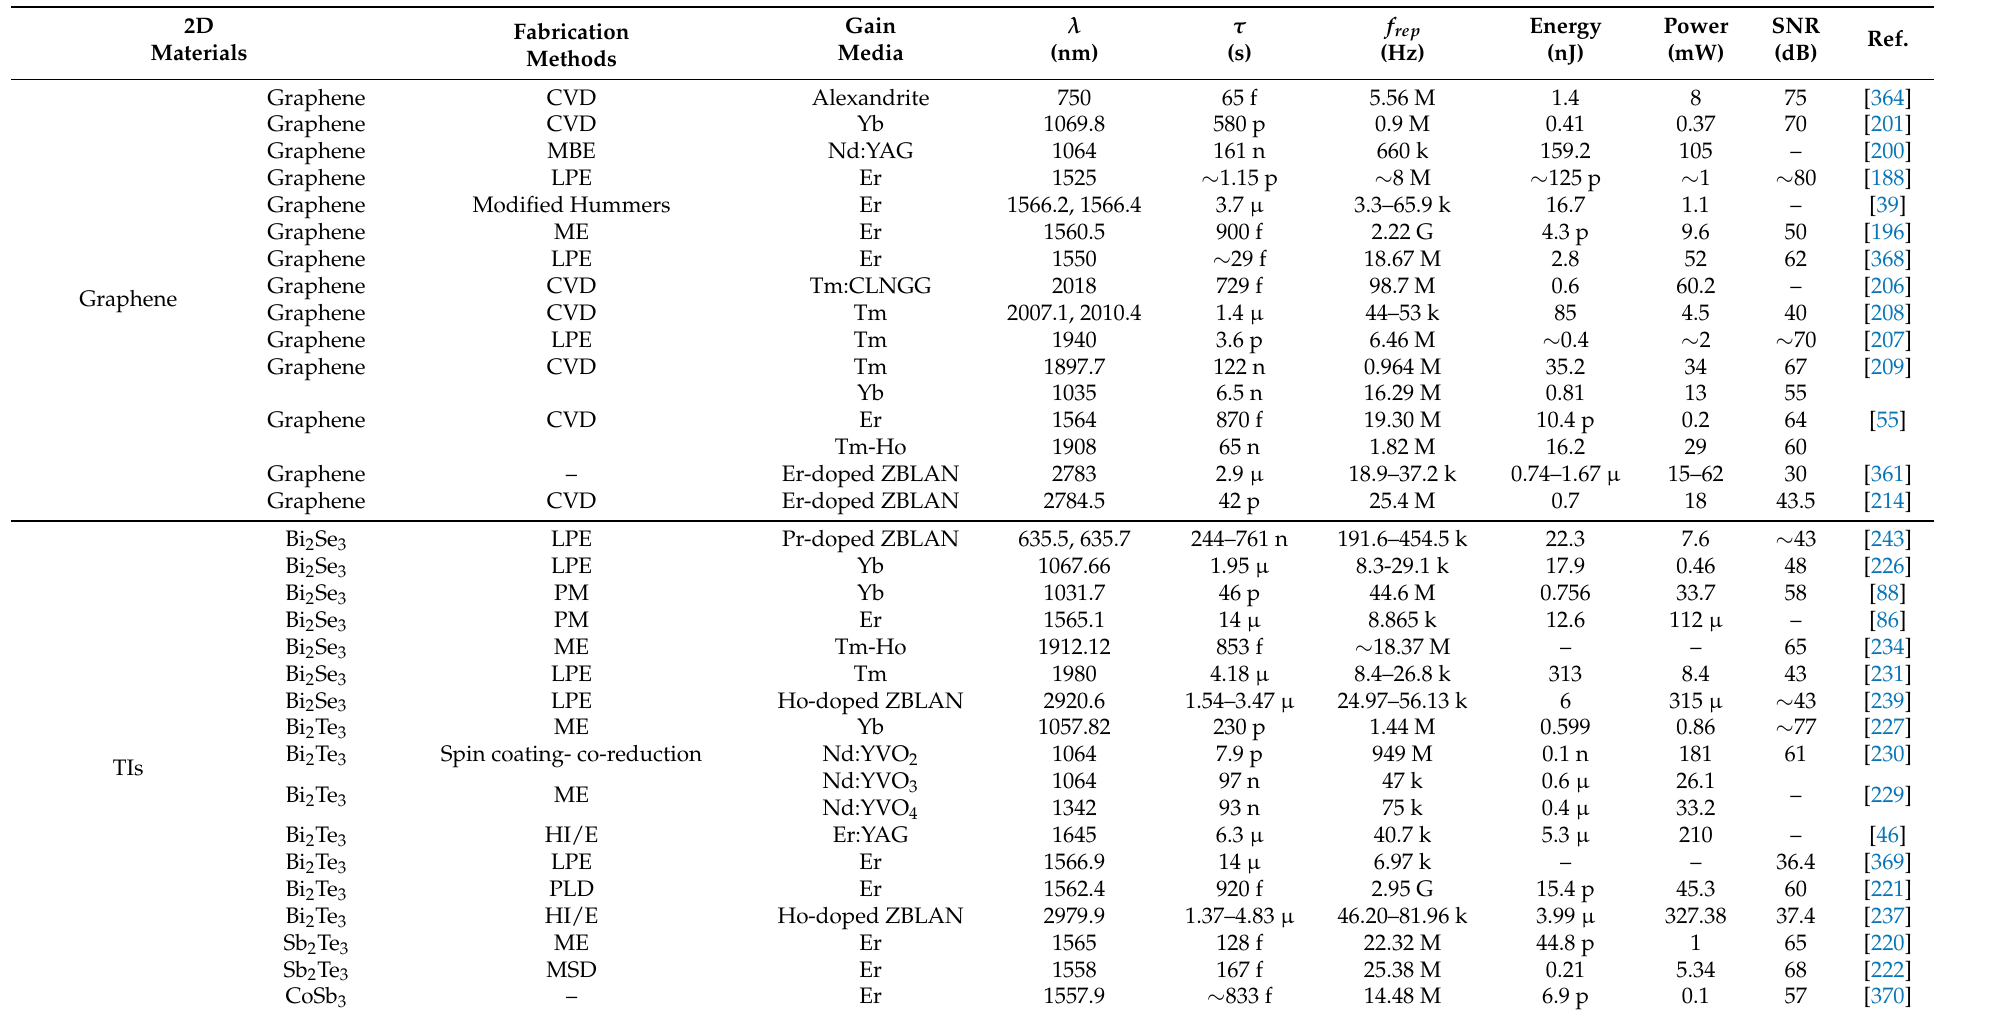
Table 1. Summary of ultrafast lasers based on 2D material SAs. Note that the results obtained from different conditions including various 2D materials, gain media, and experimental purposes.